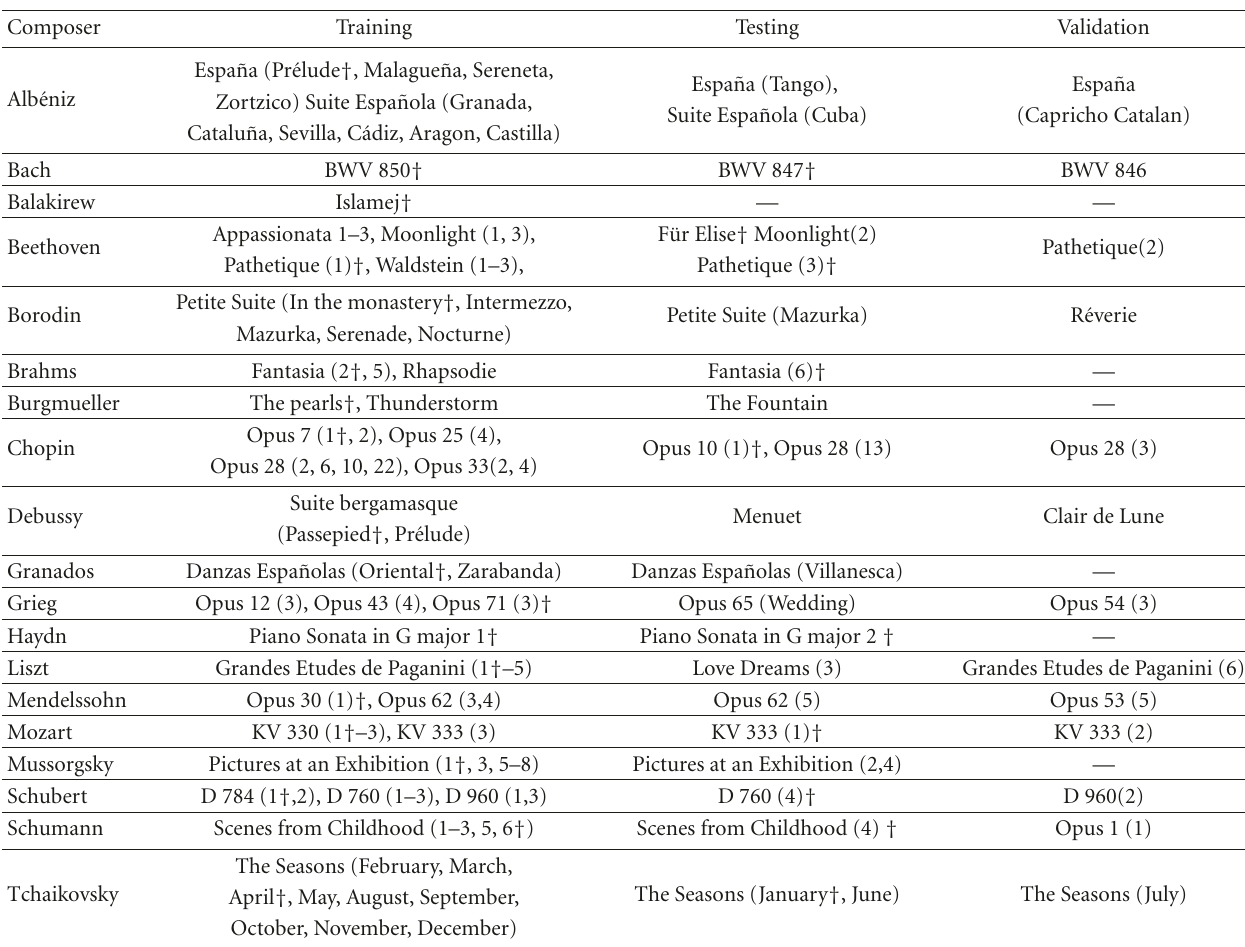
Table 5: MIDI compositions from